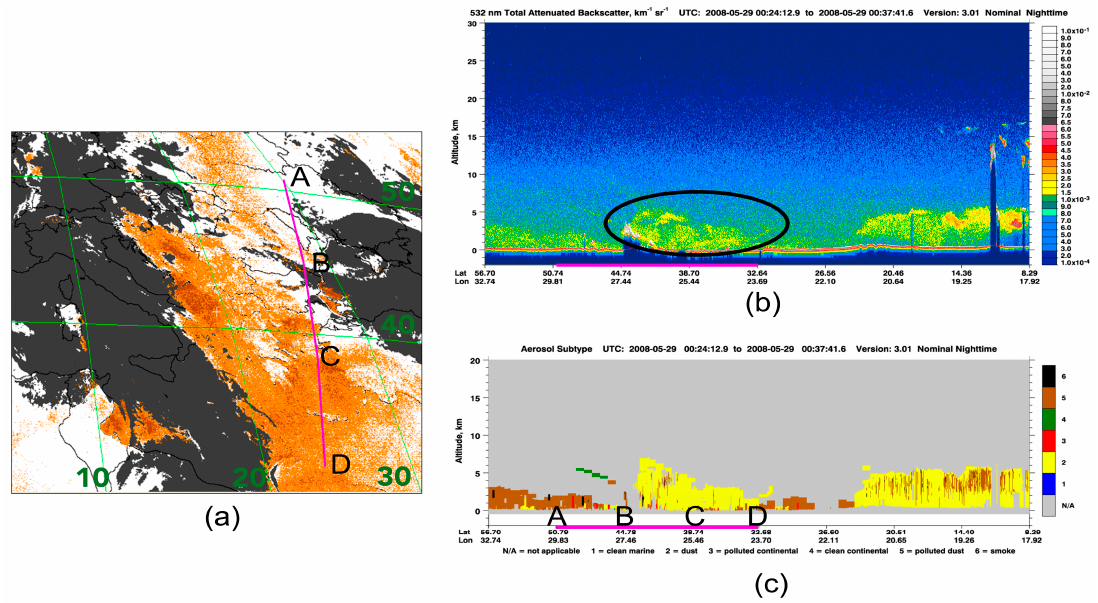
Figure 6. ( a ) Dusty pixels identified by e RST DUST on SEVIRI data of 29 May at 00:00 UTC; ( b ) Total (parallel + perpendicular) attenuated backscattered profile along the orbit track of CALIPSO (purple line in ( a ) acquired on 29 May 2008 between 00:24:12 and 00:37:41 UTC; ( c ) CALIOP aerosol sub-type profile of same day and hour.